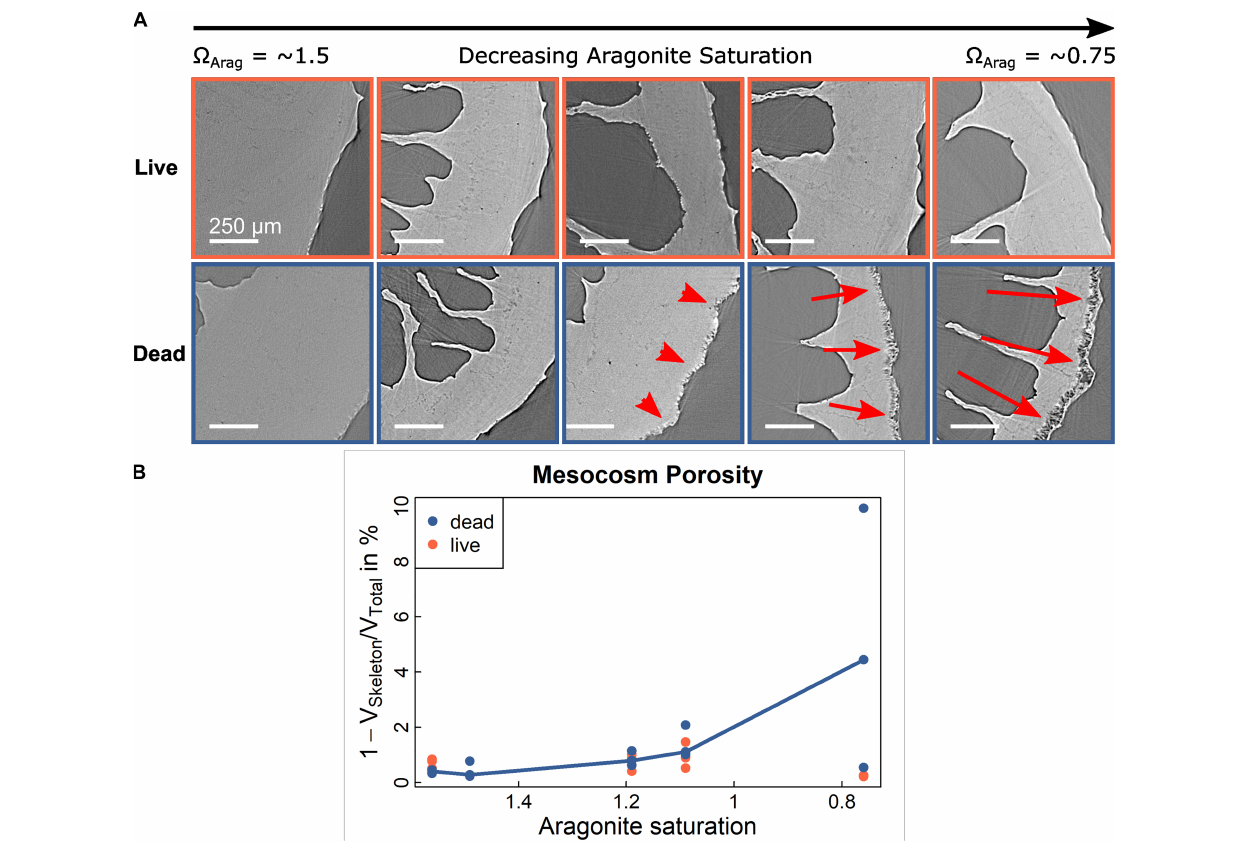
FIGURE 6 | Porosity in experimentally incubated Lophelia pertusa . (A) SR µ CT cross-section images of corals from Mingulay Reef Complex (Hennige et al., 2015a) subjected to different treatments of increased levels of CO 2 during 12 month laboratory incubations. (B) corresponding porosity analyses shows a significant, non-linear relation between porosity [red arrows in (A) ] and aragonite saturation in dead samples ( p = 0.0008, r 2 = 0.59) but no significant relationship ( p = 0.67) for live samples. Relationship is illustrated by multi-linear curve connecting the